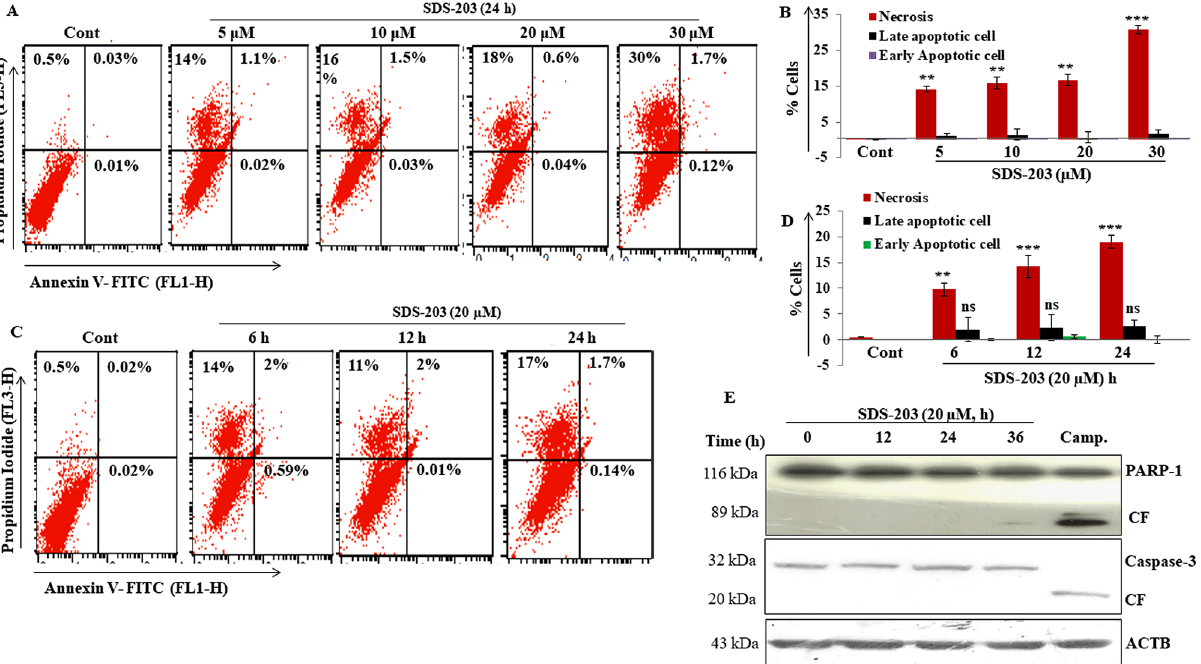
Figure 1. SDS-203 decreases cell viability by the non-apoptotic way in pancreatic cancer cell line MIA PaCa-2. ( A – D ) MIA PaCa-2 cells were incubated with different concentrations of SDS-203 (5, 10, 20, 30 µM) for 24 h or single concentration (20 µM) for various time points (0, 6, 12, 24 h) then cells were stained with Annexine-V- FITC and PI (1 µg/mL) followed by quantification of apoptotic cells by flowcytometry ( E ) MIA PaCa-2 cells were treated with SDS-203 (20 μM) in a time-dependent manner (0, 12, 24, 36 h) and protein expression of cleaved PARP1 and cleaved Caspase3 were determined by western blotting, camptothecin (1 µM) was taken as a positive control. Each experiment was repeated three times. p -value represents: ** p < 0.01; *** p < 0.001vs.